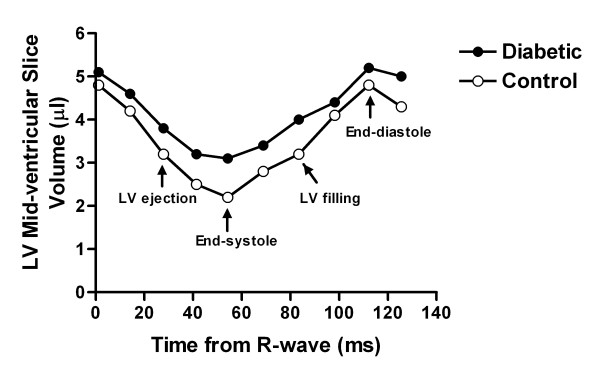
LV volume-time curves from a representative control and diabetic mouse. The LV cavity slice volume in a mid-ventricular short-axis cine image is plotted against time of acquisition within the cardiac cycle. The difference of end-systolic volumes between control and diabetic mouse is apparent, while the end-diastolic volumes are similar. The maximum ejection rate and maximum filling rate calculated from these curves both are decreased in diabetic mice.